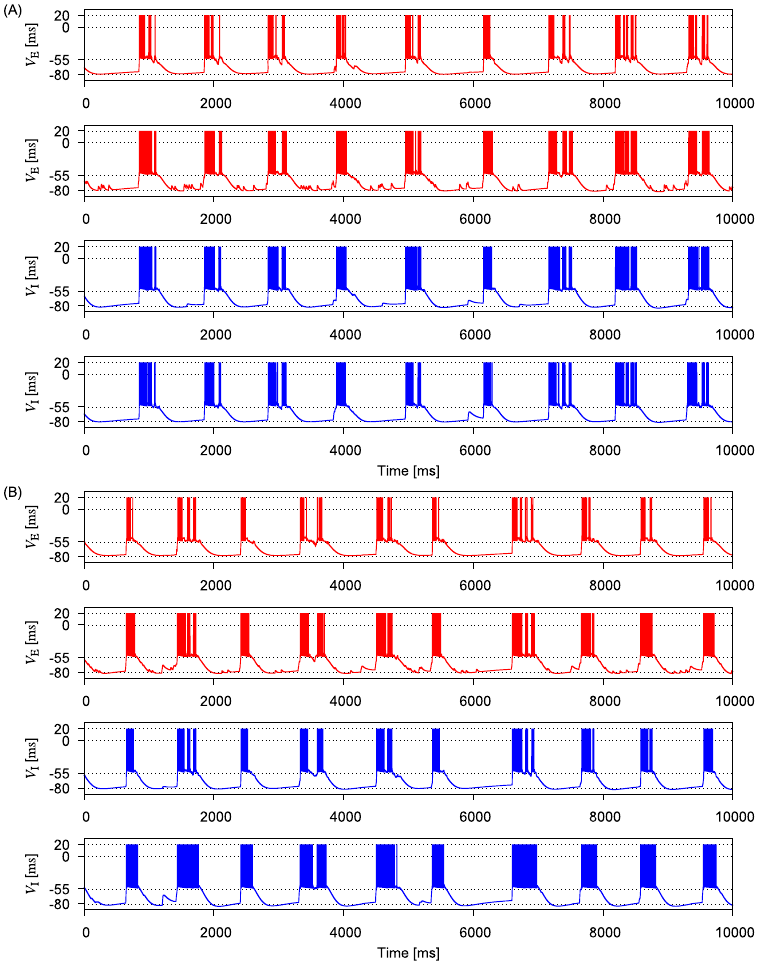
Figure 4. Network activity obtained for sparse-Gaussian and sparse-log-normal weight distributions. ( A ) Membrane potentials of two excitatory neurons and two inhibitory neurons are shown for a sparse-Gaussian weight distribution parameterized as γ E = 0.1 and σ E = 10. ( B ) Membrane potentials of two excitatory and two inhibitory neurons are displayed for a sparse-log-normal weight distribution with parameters γ E = 0.1 and = σ E